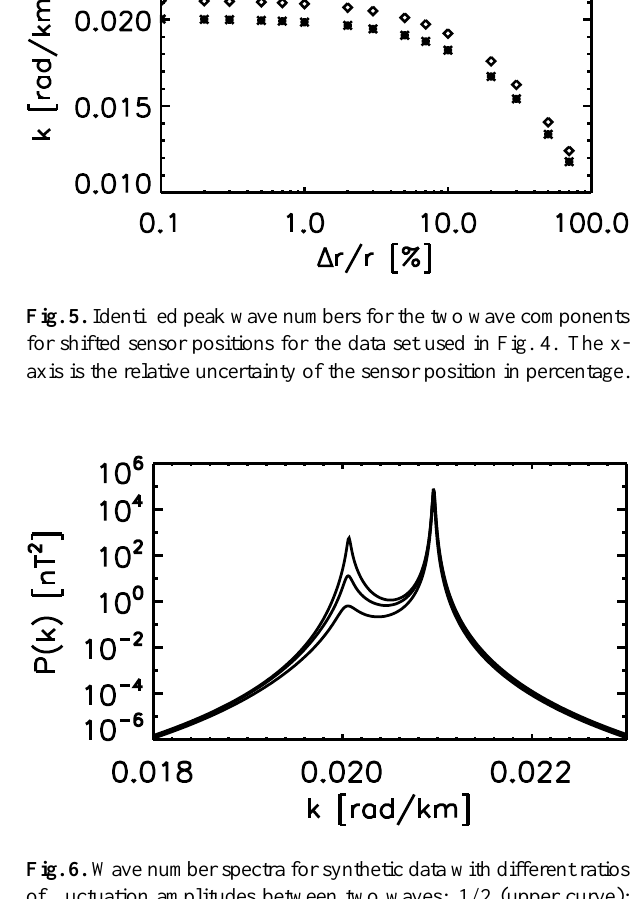
the spectra exhibit peaks at almost the right wave numbers.